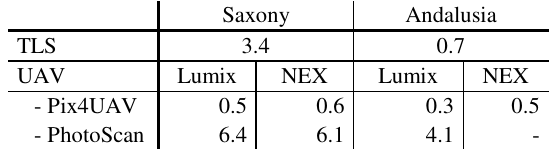
Table 2. Average point density [points/cm²] Before the actual accuracy analysis of UAV data a short accuracy control of TLS data needs to be performed. TLS registration error between the different scan positions for a single time interval ranges between 4 and 6 mm. For multi- temporal comparison target coordinates of the first interval, which were transformed to the local reference system, are assigned to the following measuring phase, if no GCP movement has been verified by total station control. Hence, adverse error propagation due to separately conducted